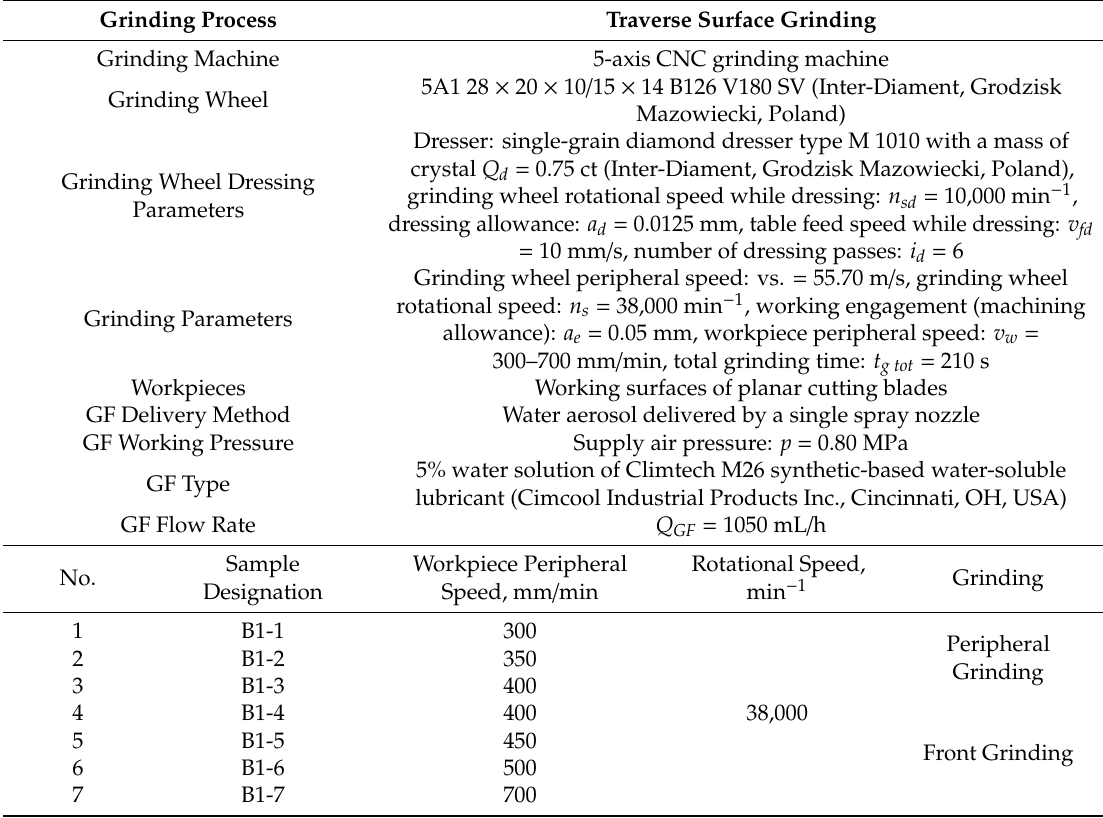
Figure 3. Central part of a five-axis CNC (Computerized Numerical Control) grinding machine: ( a ) general view; ( b ) close-up of the grinding wheel 5A128 × 20 × 10/15 × 14B126V180SV mounted in electro-spindle PTShPp-30-36Km120 Table 3. Machining conditions.